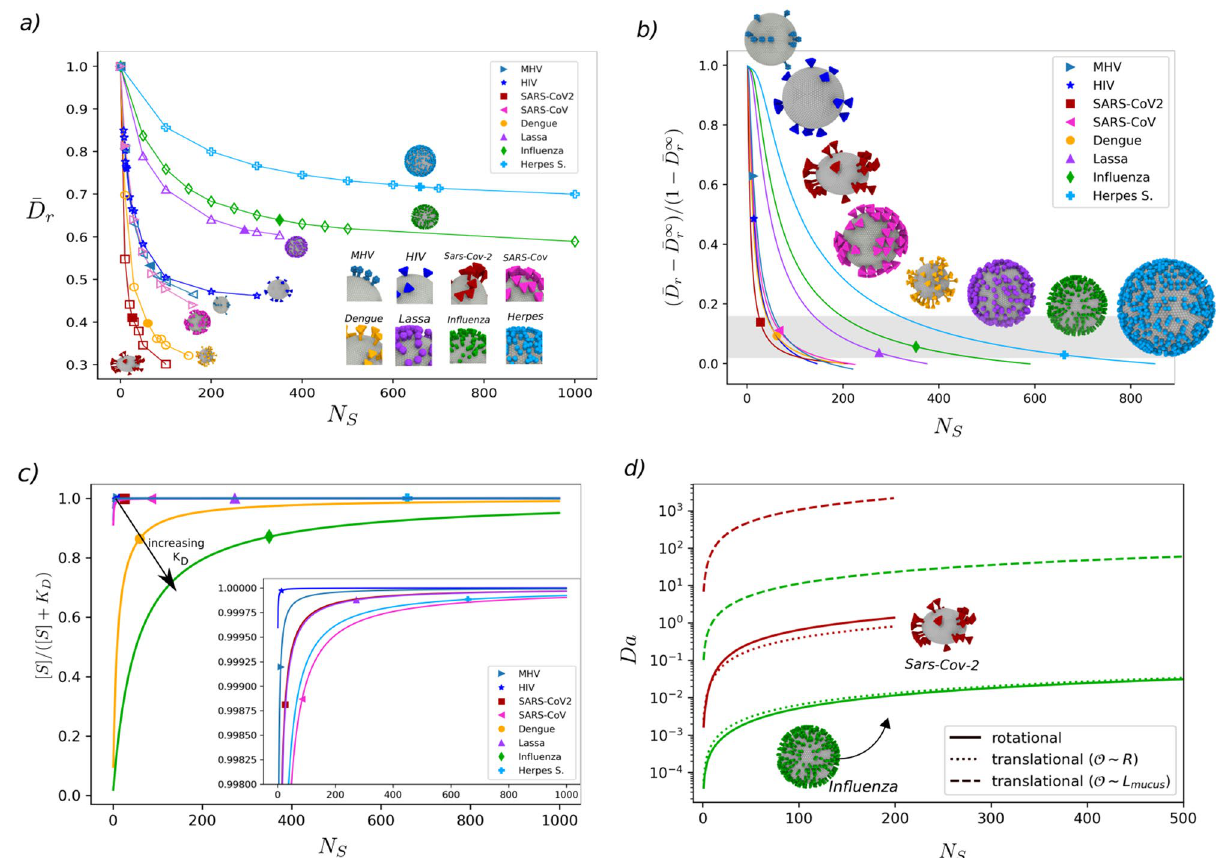
Figure 3. Interplay between virion rotational diffusion and receptor binding affinity for SARS-CoV-2 and selected viruses. ( a ) Effect of N s on the rotational diffusion. Each virion family exhibits a characteristic reduction on its mobility reaching an asymptotic value for large N s . The maximum N s evaluated for the different viruses correspond to the condition where surface proteins overlap. SARS-CoV-2 shows the sharpest drop in diffusion, whereas for Herpes Simplex the reduction occurs over a much larger N s range. Inset: Snapshots of the morphologies used to represent each virion type. In the Methods Section we include the reported crystal structure and sizes of the surface proteins for comparison. ( b ) Dependence of the excess rotational diffusion with N s (fitted from Eq. (1)) for different viruses. Filled markers indicate the experimentally reported N s for the different viruses. For the majority of viruses modelled the mean values of the excess diffusion (translational and rotational) are (cid:31) D t ∼ 0.08 and (cid:31) D r ∼ 0.12 , elucidating a characteristic trend in their mobility state regardless of the type of virus and N s . This suggests the existence of a general transport mechanism across enveloped viruses. This ground state is likely induced as a balance between their geometrical features and S reactivity. The higher (cid:31) D r in HIV and MHV can be explained due to an enhanced mobility of S on the E surface. Such effect is not currently accounted in our model. The fitting parameters obtained from fitted from Eq. (1) are summarized in Table 2 and SI Sect. 9. ( c ) Saturation function change with N s for various virus based on their binding constant K D to cellular receptors. The magnitudes of K D are summarized in Supplementary Table